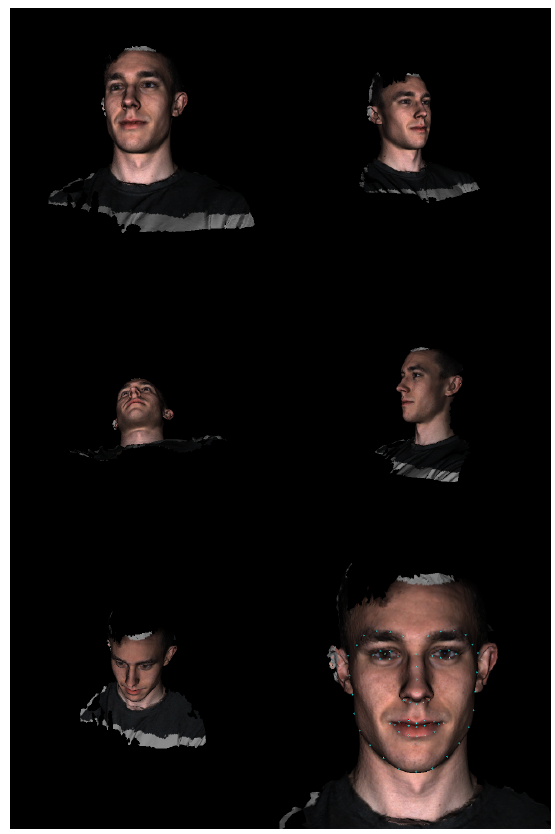
Figure 4. The five initial images of a 3D facial surface scan along with the refined frontal image (bottom right) annotated with the 68 2D landmarks (blue circles) identified by the 2D landmarking